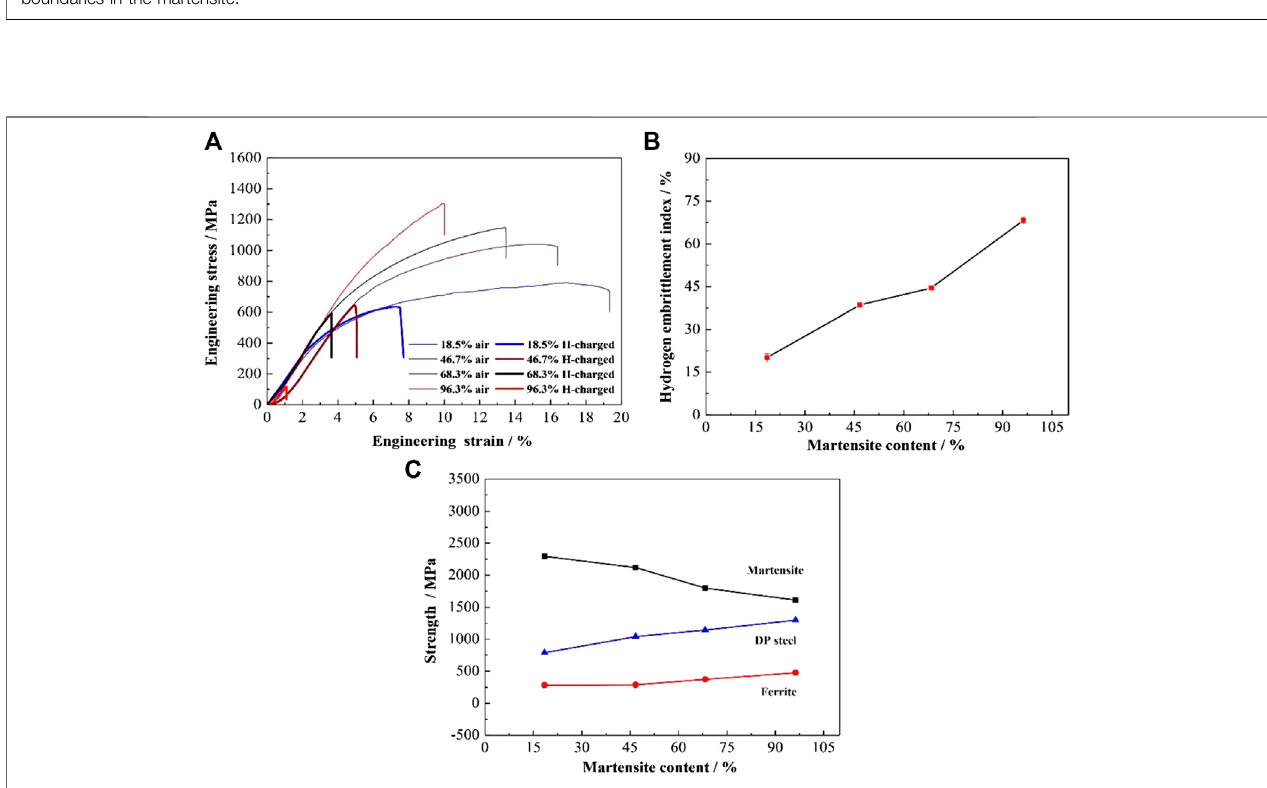
FIGURE 4 | (A) Stress-strain curves; (B) hydrogen embrittlement susceptibility; and (C) strength of ferrite and martensite of DP samples with different martensite content.